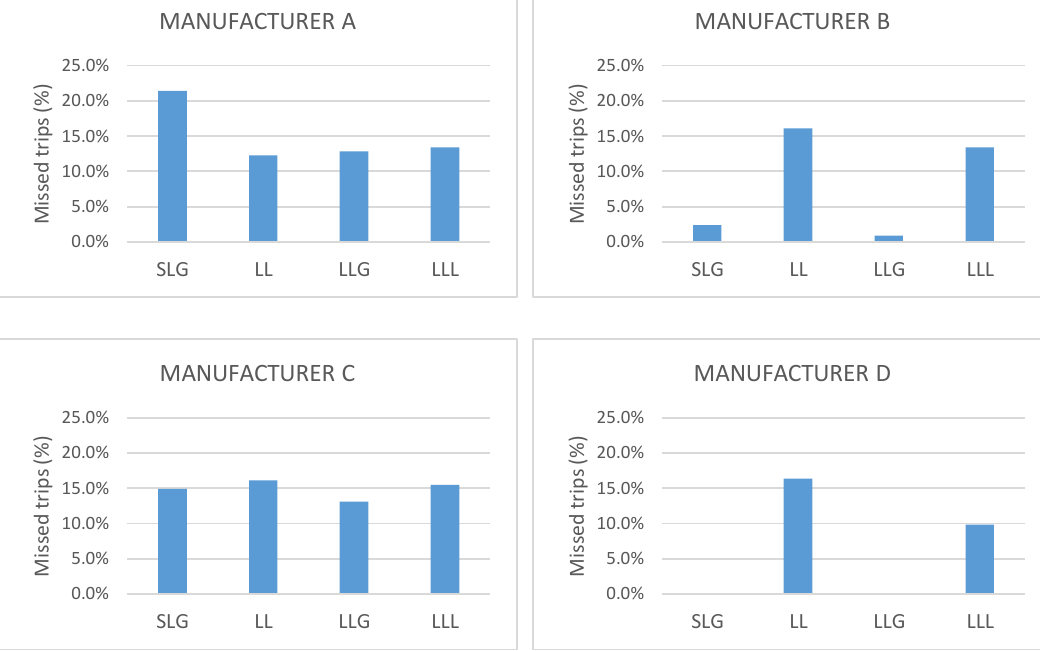
Figure 3. Distribution of missed trips between different types of faults for the four different vendors (percentage of missed trips over the total number of faults) for 100% renewables scenario for type 4-WT.